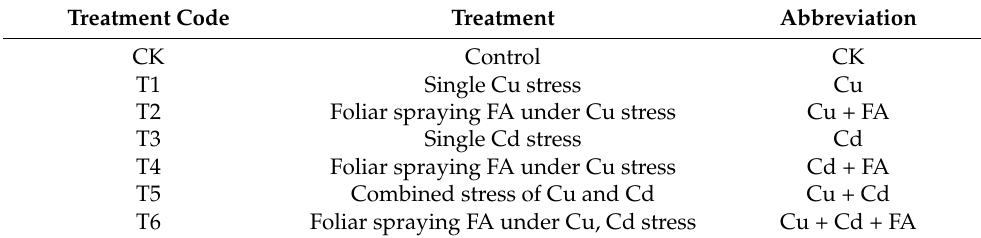
Table 2. The experimental